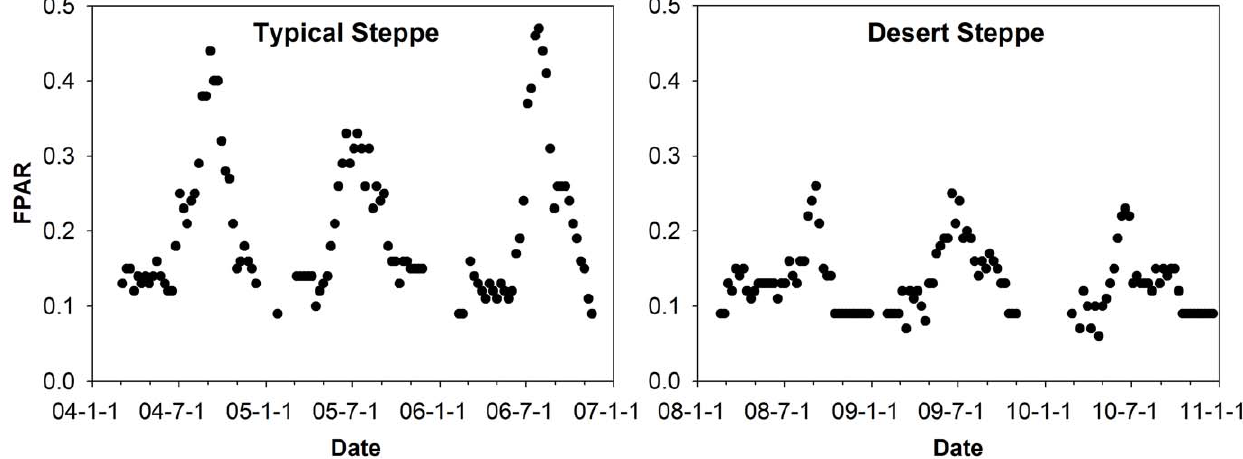
Figure 2. Seasonal variations of fraction of photosynthetically active radiation absorbed by plant canopy (FPAR, from MODIS product) at the two sites.